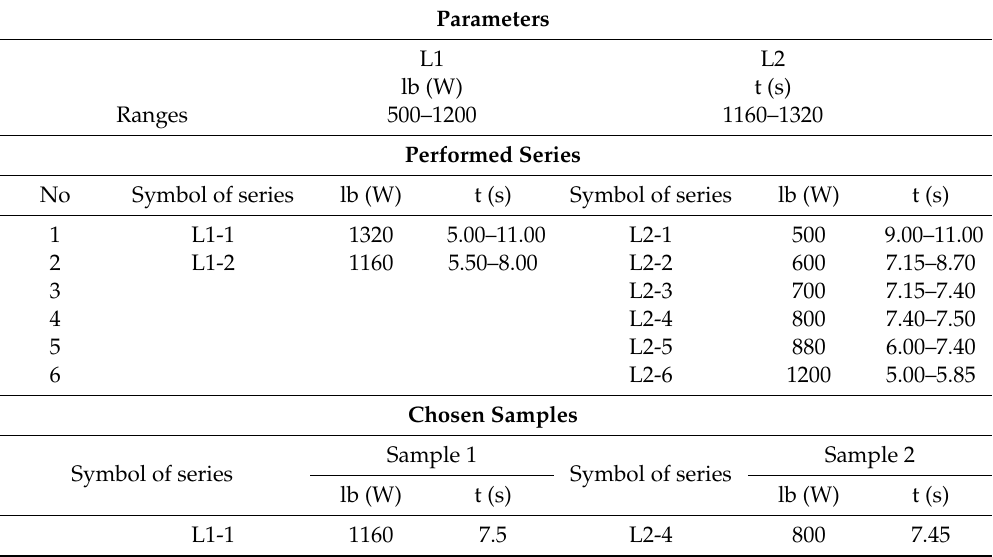
Table 2. Processing parameters for copper oxide layers.